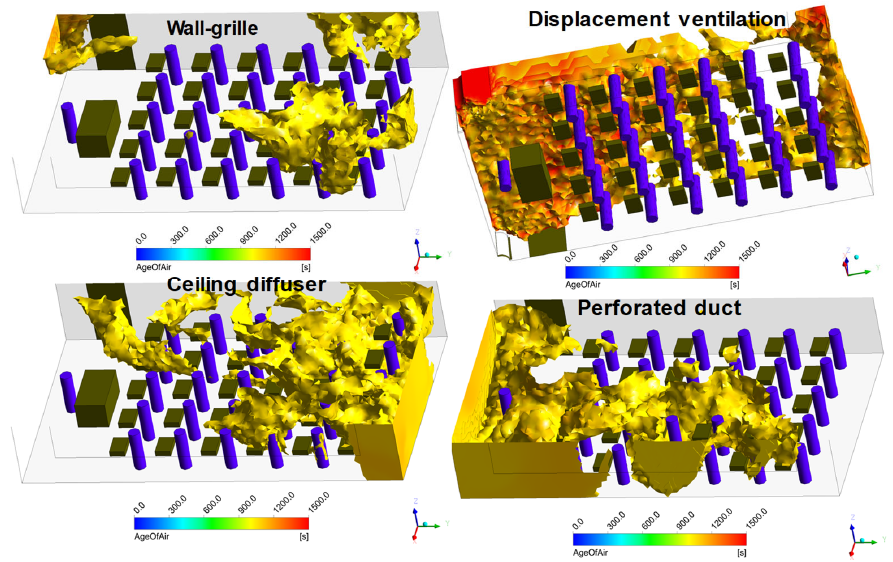
Figure 6. Iso-volume visualization of age distribution of air in the occupied zone over 1063 s (fully mixed condition) in the summer.